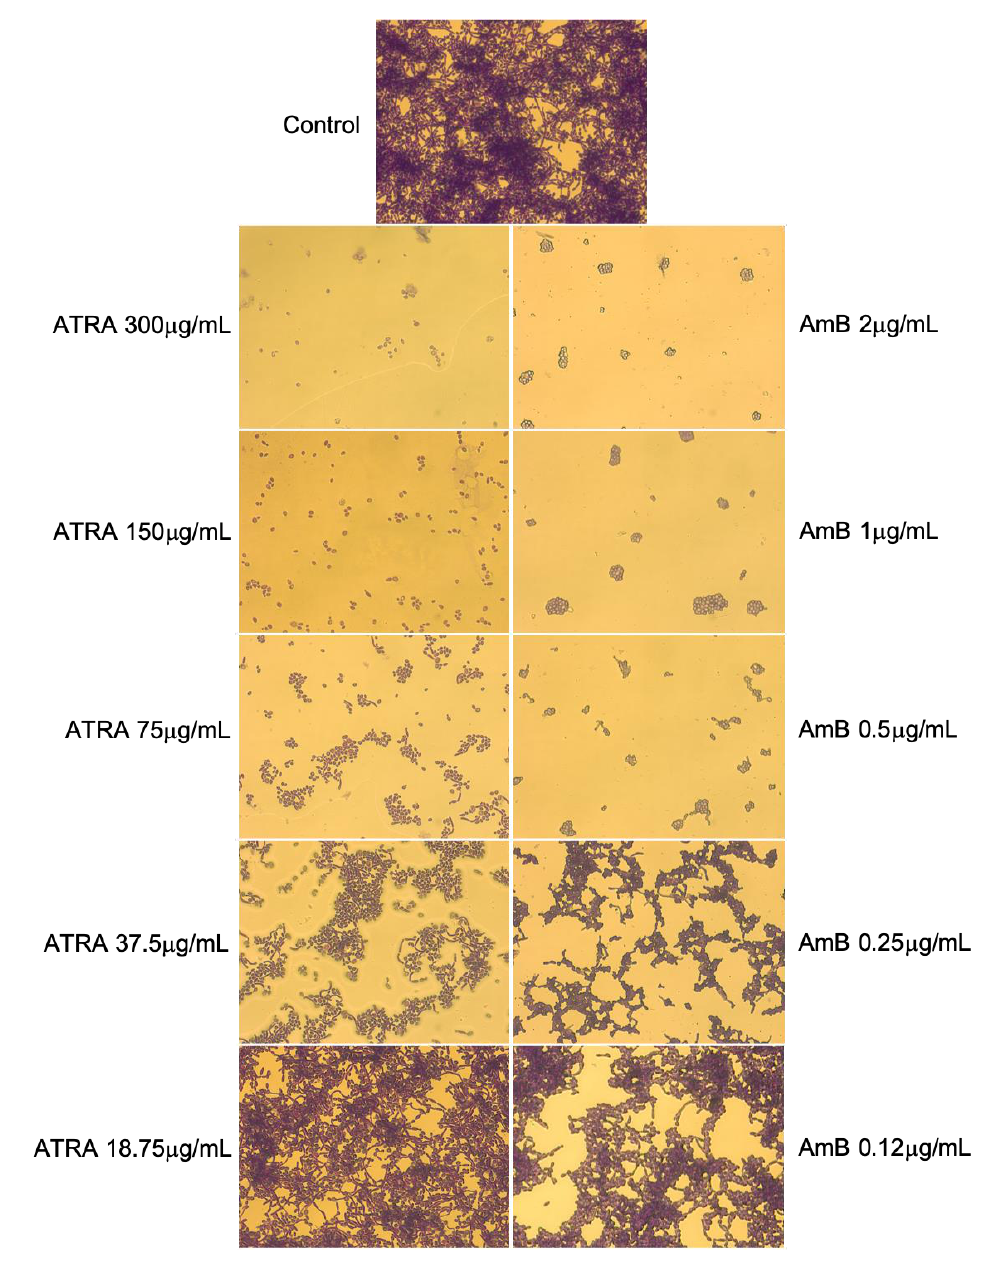
Figure 4. Effect of ATRA on phenotypic switching of C. albicans . Candida cultures were incubated for 24 h in the absence or presence of ATRA at different concentrations (300–18.75 µg/mL). The phenotypic transition from yeast-to-hyphal morphotype was analyzed by light microscopy after crystal violet staining. AmB was used as positive control drug. The images were acquired by a light microscope (Olympus, Carl Zeiss, UK) with 40× magnification objective lenses. One representative experiment of three is shown.